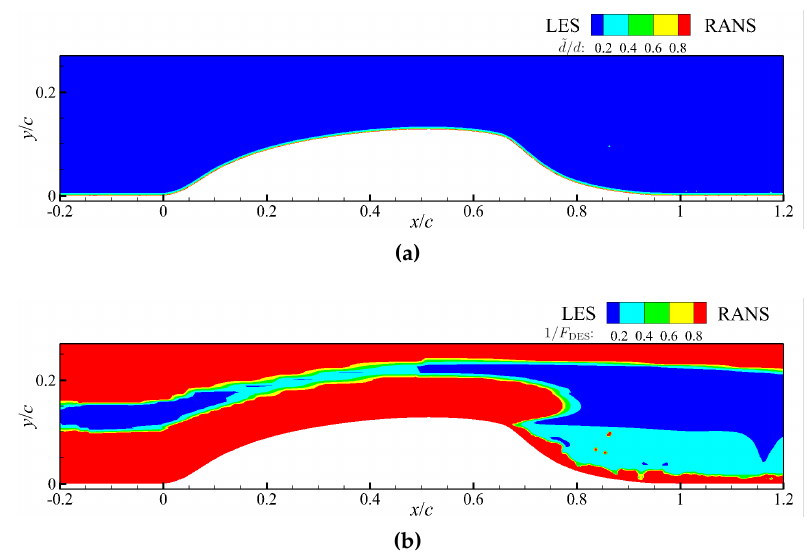
Figure 12. Action regions of RANS and LES obtained by: ( a ) SA-DES and ( b ) SST-DES.